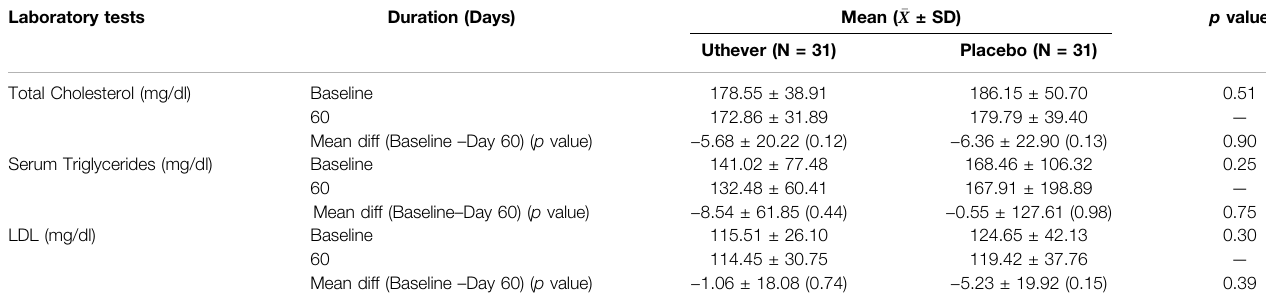
TABLE 13 | Comparison of mean laboratory data (Lipid pro fi le) between